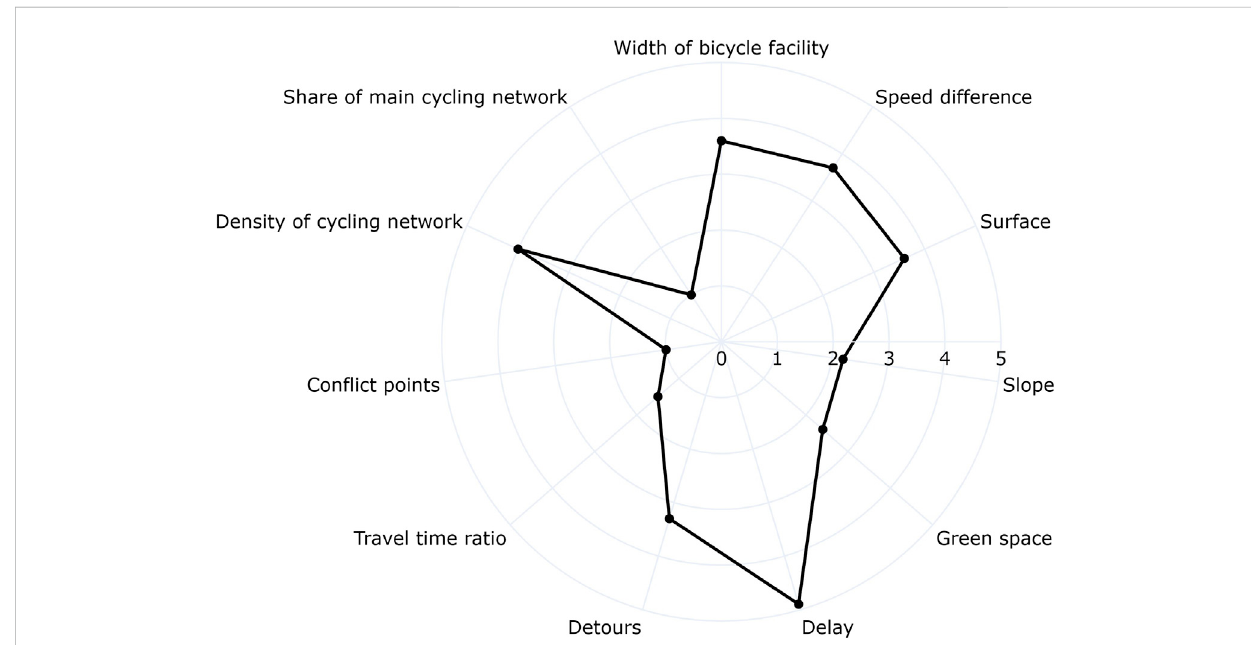
FIGURE 2 Quality assessment of the Munich bicycle network per sub-criterion (1-very poor, 2-poor, 3-medium, 4-good, 5-very